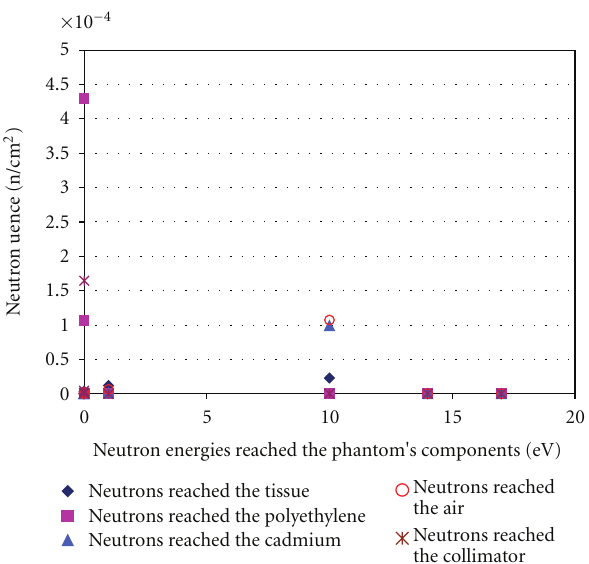
Figure 13: The neutron fluence in the phantom’s compo- nents obtained by